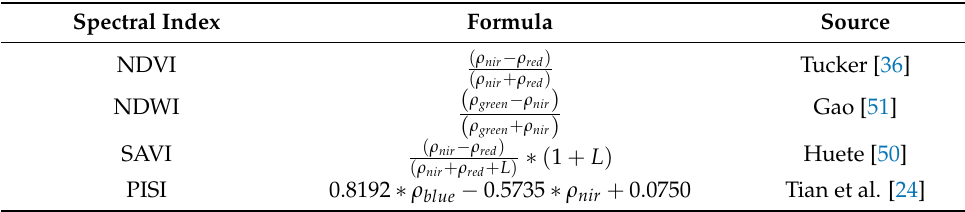
Table 2. Spectral Indices used in this study and their corresponding